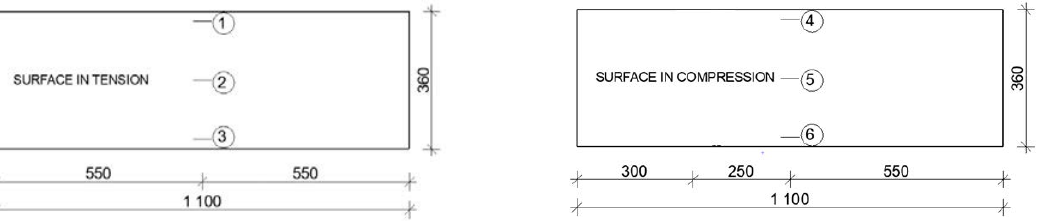
Fig. 3 Position of strain gauges on lower and upper surface of laminated glass panel at all